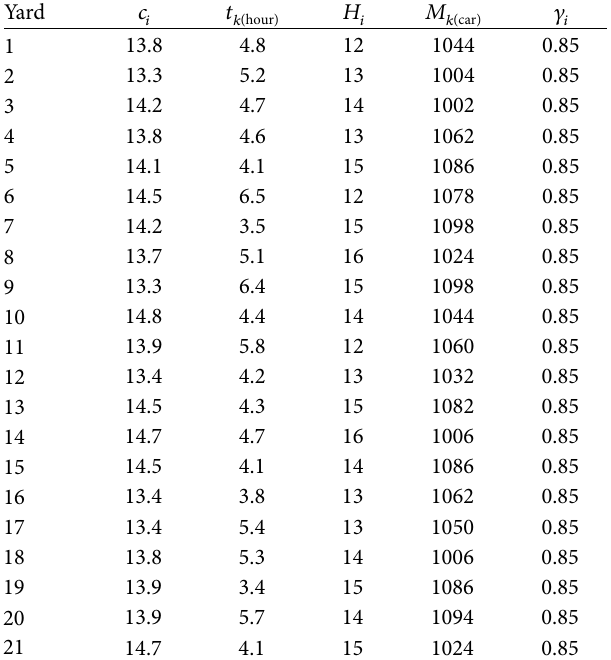
Table 3: Technical parameters of each